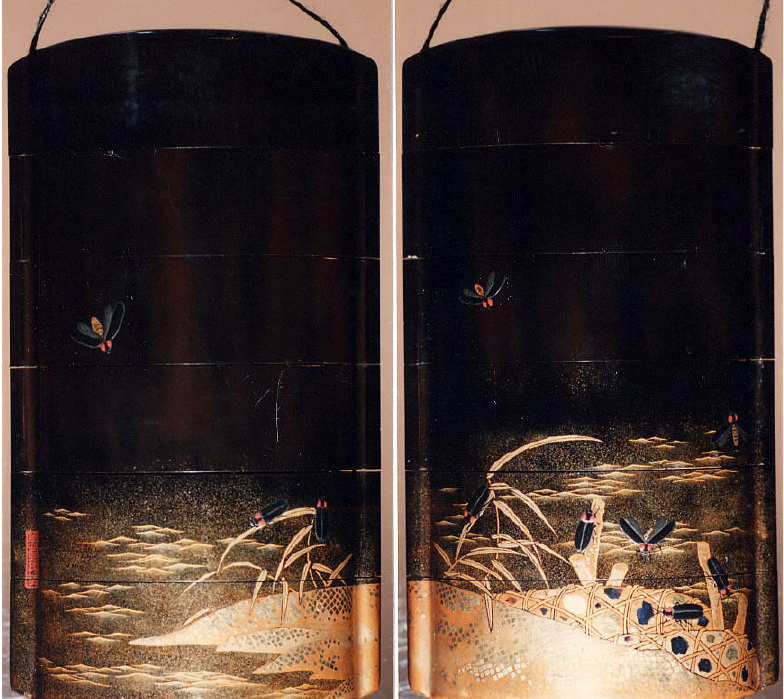
Figure 1. (T100). Two sides of Case (Inrō) with Design of Fireflies in Flight and Climbing on Stone Baskets and Reeds at the Shore. Noneteenth C. Unknown artist (Japanese). Lacquer, roiro, gold